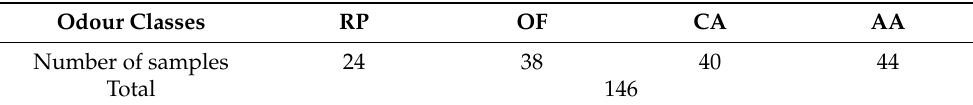
Table 2. Training samples